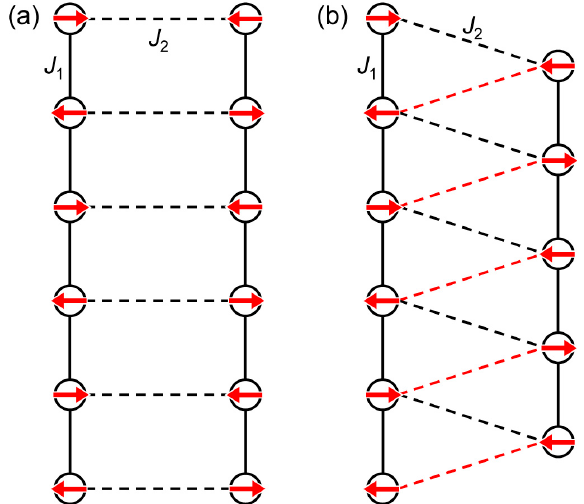
Figure 1. Two chains of magnetic moments with antiferromagnetic (AFM) exchange coupling both within ( J 1 ) and between ( J 2 ) the chains. While all pairwise AFM interactions can be satisfied in the arrangement ( a ), spin frustration develops in the arrangement ( b ) due to the half-period shift be- tween the chains. This shift results in the orientation of spins that conflicts with the AFM ex-change constant J 1 (the conflicting interactions are highlighted in red).